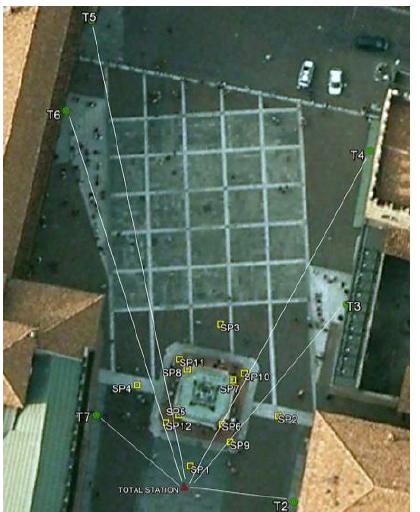
Figure 4. The scan positions of the laser scanner survey (yellow squares) and the targets used for the definition of the reference system (green circles).